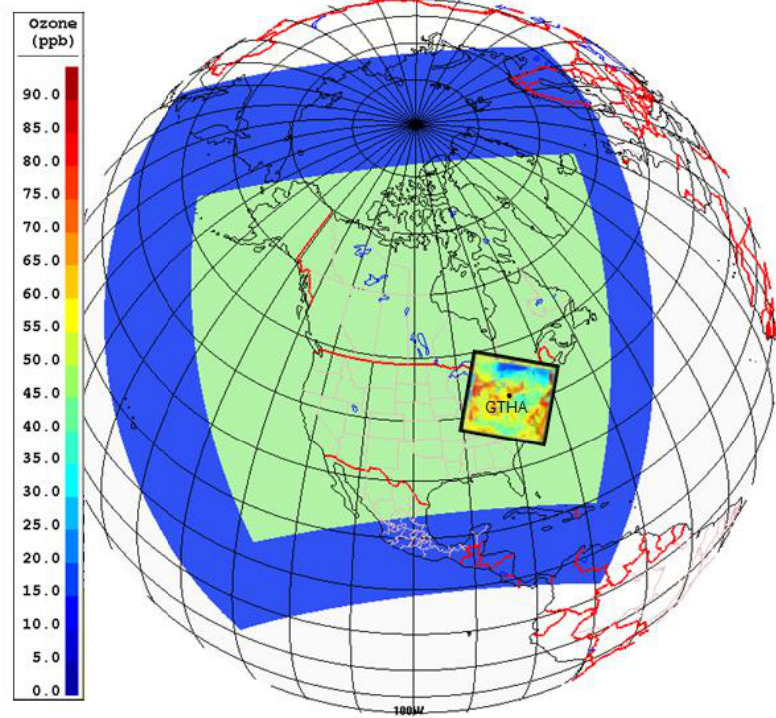
Figure 3. Nested domains used for weather and air quality forecasting. The outer blue domain is for Environment and Climate Change Canada’s (ECCC’s) 10-km regional global environmental multi-scale (GEM) weather forecast model. This outer domain provides the meteorological boundary conditions for the 10-km regional GEM-modelling air quality and chemistry (MACH) model domain, shown in green. The 10-km GEM-MACH in turn provides the meteorological and air quality boundary conditions for the 2.5-km GEM-MACH-town energy balance (TEB) model domain, shown with the predicted ozone contours. The Greater Toronto Hamilton Area (GTHA) is centered in the 2.5-km GEM-MACH-TEB domain.